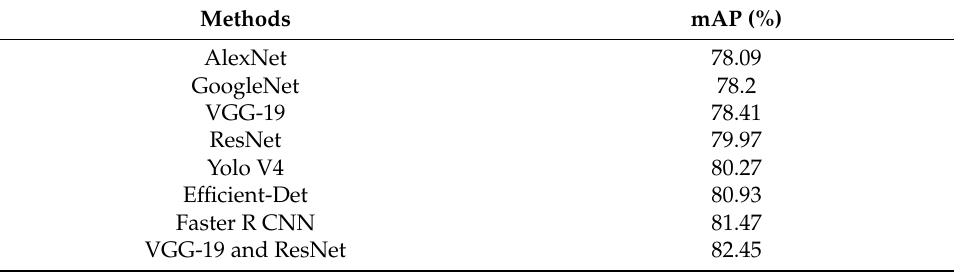
Table 1. Deep learning model feature extraction performance on DOTA